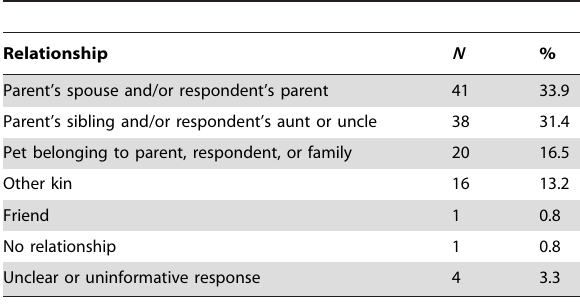
Table 2. Accidental non-sibling name substitutions categorized by relationship ( N